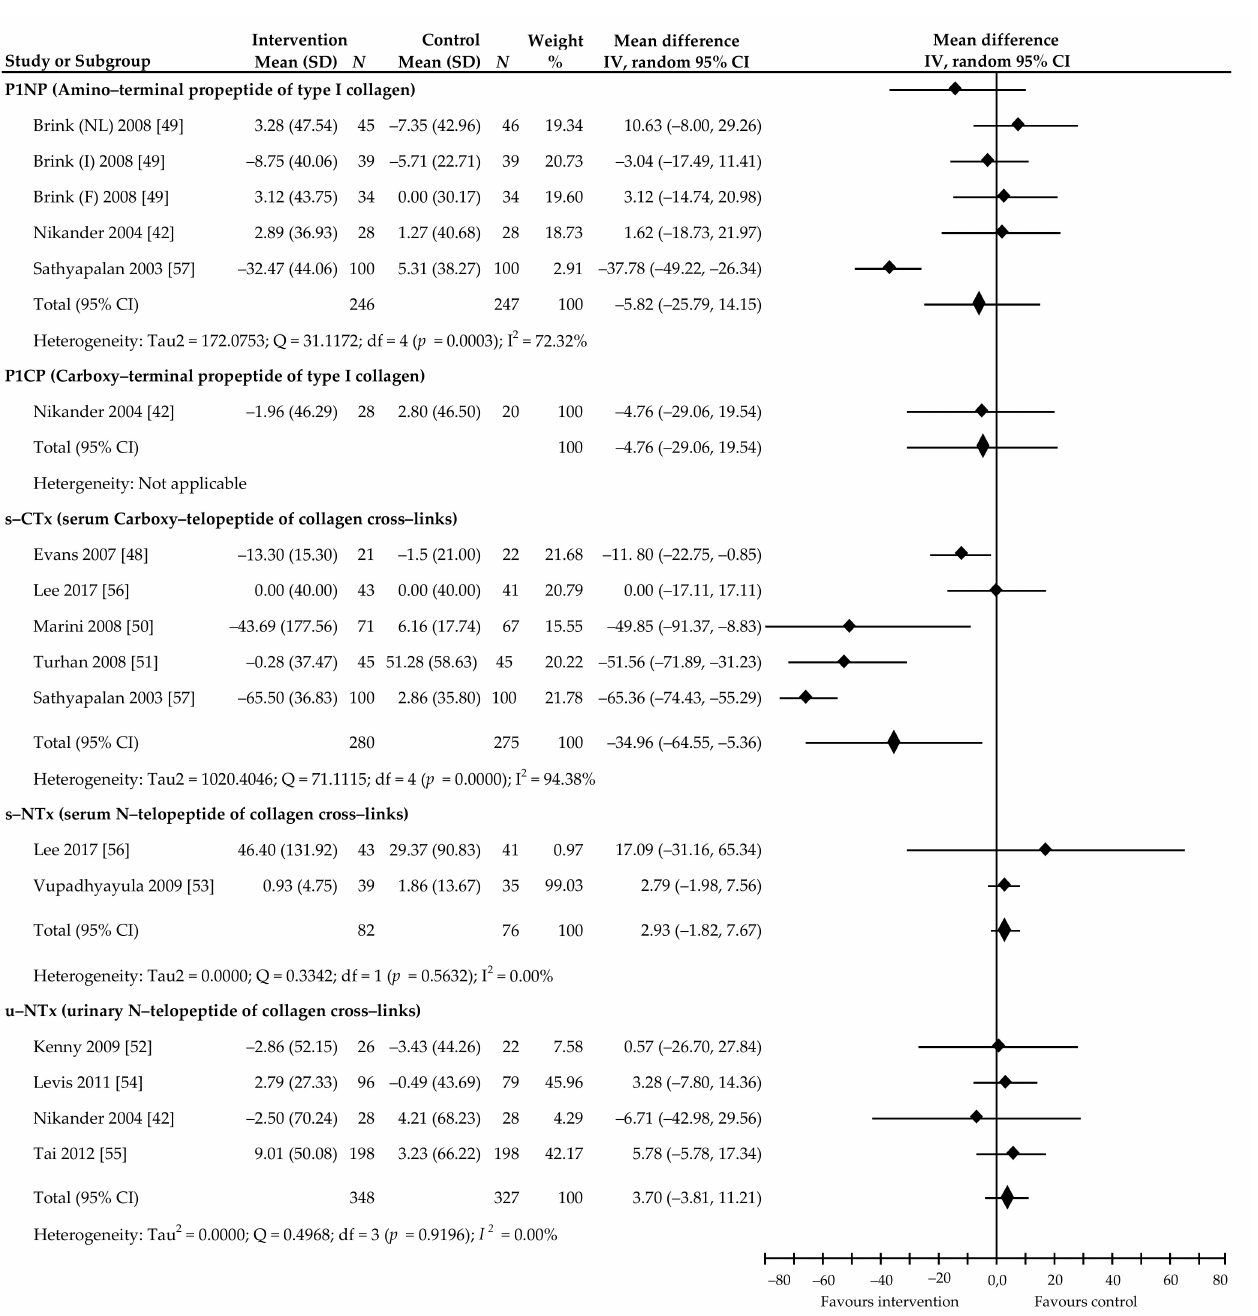
Figure 8. Percentage changes in P1NP, P1CP, serum CTx, serum NTx, and urinary NTx values associated with intake of soy isoflavones compared with placebo. Note: abbreviations of the names of the countries where the study was conducted (NL, the Netherlands; I, Italy; F, France) are in brackets following the name of the lead investigator; data calculated from the random-effects model are presented as weighted mean difference; IV, inverse variance; df, degrees of freedom; the horizontal lines denote the 95%